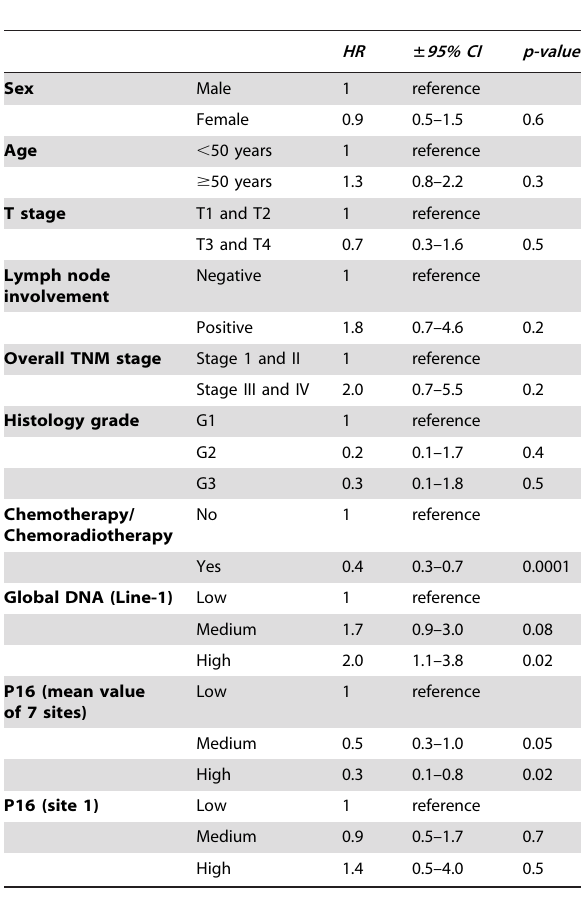
Table 2. Multivariate survival analysis of prognostic factors in GC